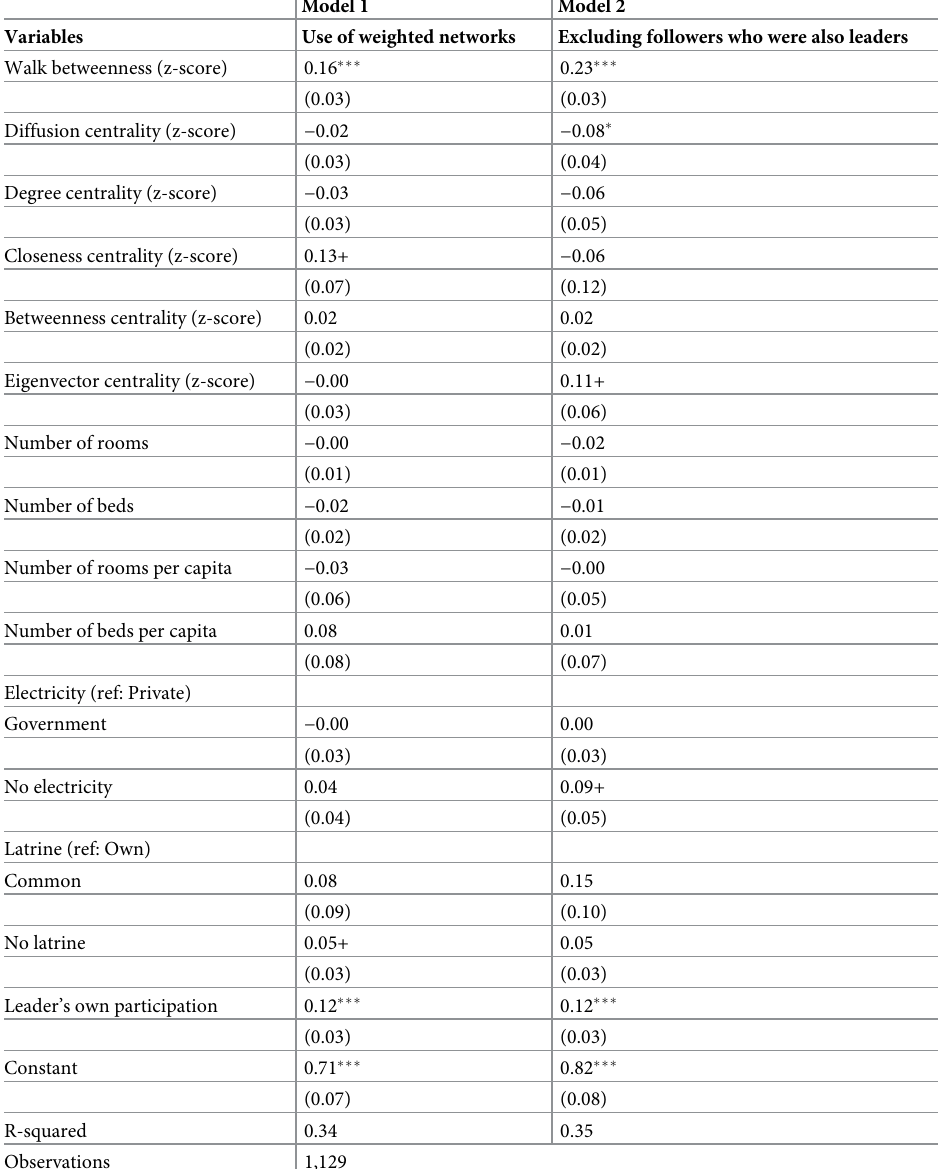
Table 6. Village-fixed effects regression models for the followers’ microfinance take-up rate among leader house- holds in the 75 Indiana villages: Robust